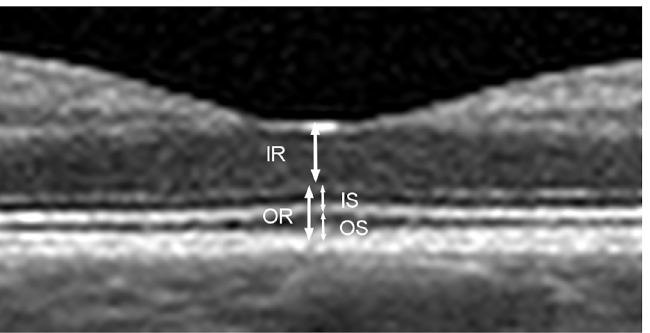
Fig 1. Retinal layers. Central foveal cross-section of optical coherence tomography (OCT) of a normal eye illustrating the measurements: Inner retina (IR), from the internal limiting membrane to the inner margin of the external limiting membrane (ELM). Inner segment (IS) of the photoreceptor layer, from the inner margin of the ELM to the outer margin of the ellipsoid zone (EZ). Outer segment (OS) of the photoreceptor layer, including the outer photoreceptor segment and the interdigitation zone. The outer retina (OR) is composed of IS and OS